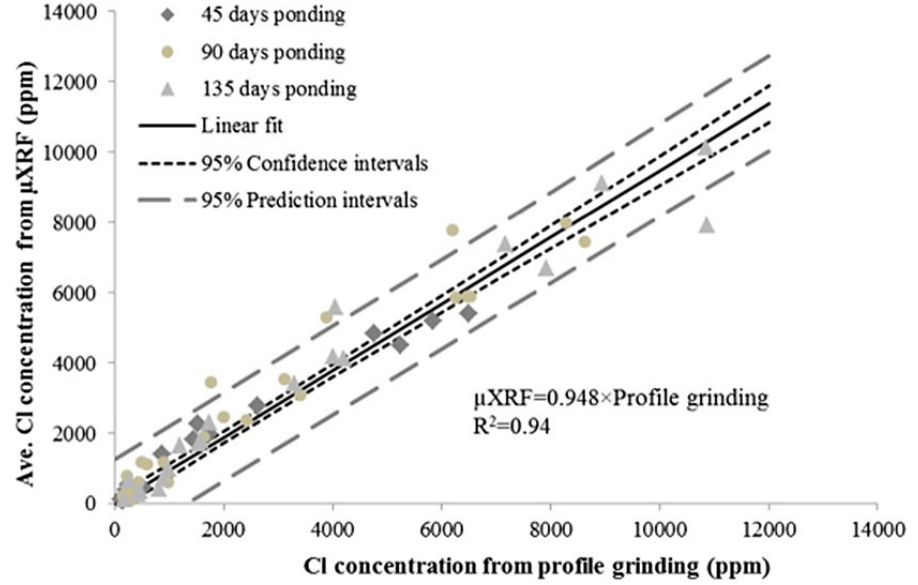
Figure A3. Correlation between results from µXRF and profile grinding [17].